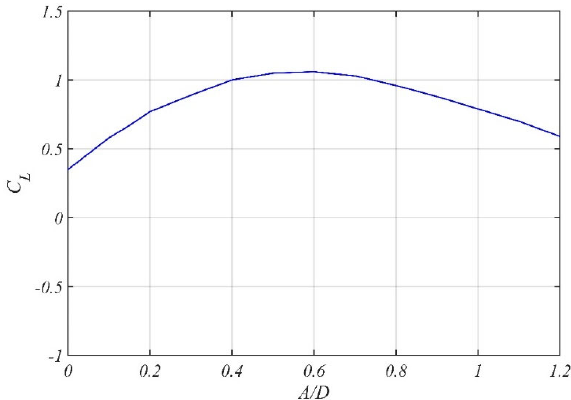
Figure 2. Lift force coefficient ([25]).